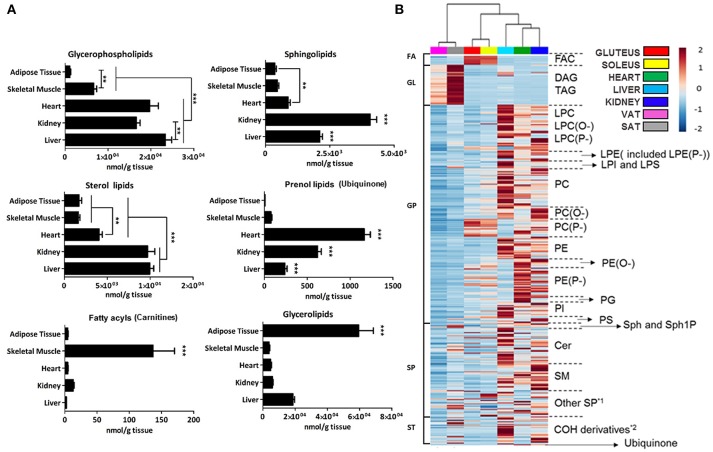
Lipid species concentration and distribution across the tissues analyzed by a targeted lipidomic approach. (A) Graph representation of average concentration in nmol/g of tissue of lipid species detected by targeted lipidomics grouped by families. Error bars denote SEM across 7–9 animals. Adipose tissue is comprised of visceral and subcutaneous tissue while gluteus and soleus comprised skeletal muscle. Kidney is represented only by the renal cortex. Statistical analysis performed was one-way ANOVA and post-hoc Tukey multiple test. **p < 0.01, and ***p < 0.001. (B) Heat map of abundance of the detected lipid species across samples. Each line represents one compound colored by its normalized abundance to internal standard, baseline and mean across samples. The scale from 2 to −2 represents the normalized abundance of each lipid in arbitrary units. *1 gangliosides and sulfatides; *2 hydroxycholesterol, desmosterol and cholesteryl esters.